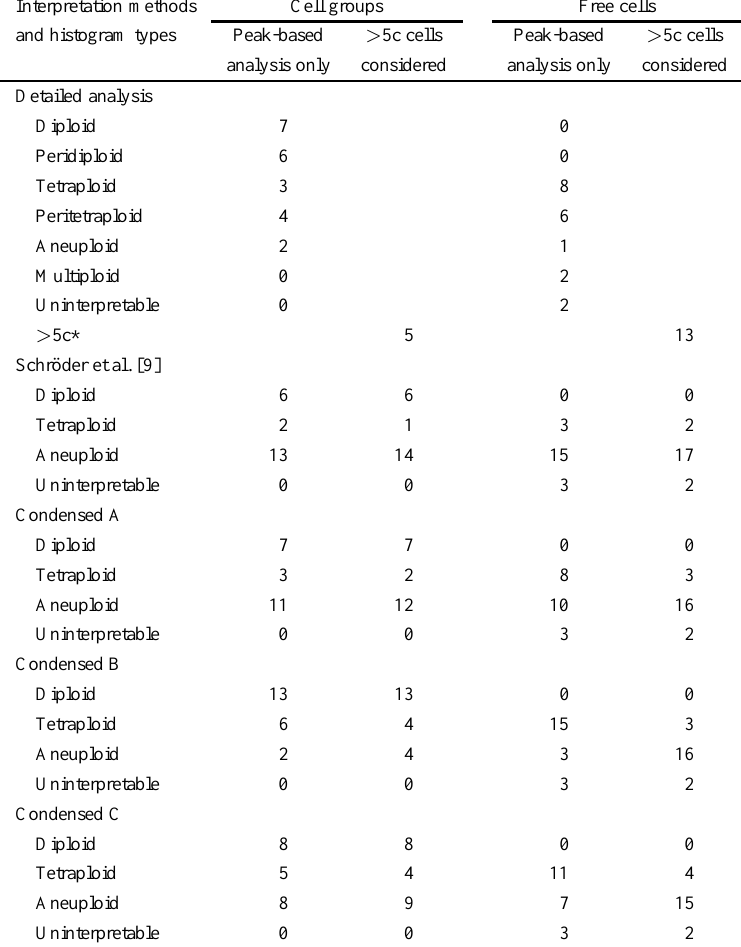
The distribution of histograms in different histogram type categories according to different interpretation methods (Detailed analysis, Method of Schröder et al. [9], Condensed classifi- cations A–C), and according to whether > 5c cells present in the sample are or are not consid- ered as definite signs of aneuploidy. The material was 21 definitely malignant FNAB samples, sampled either from cell groups or free cells between cell